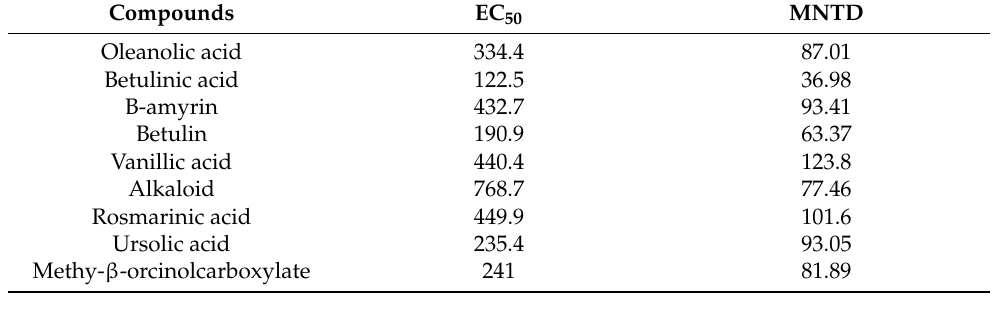
Table 2. The maximal non-toxic dose and 50% effective concentration of plant-based compounds against HeLa cells were determined. The maximum non-toxic dose and the EC 50 of the plant-based compounds were determined through the conduction of MTT assay.